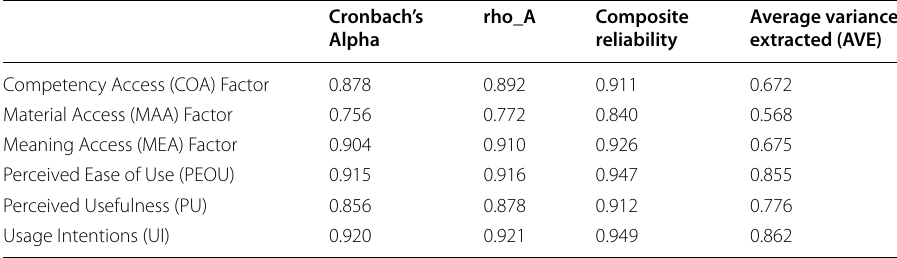
Table 3 Construct validity and reliability